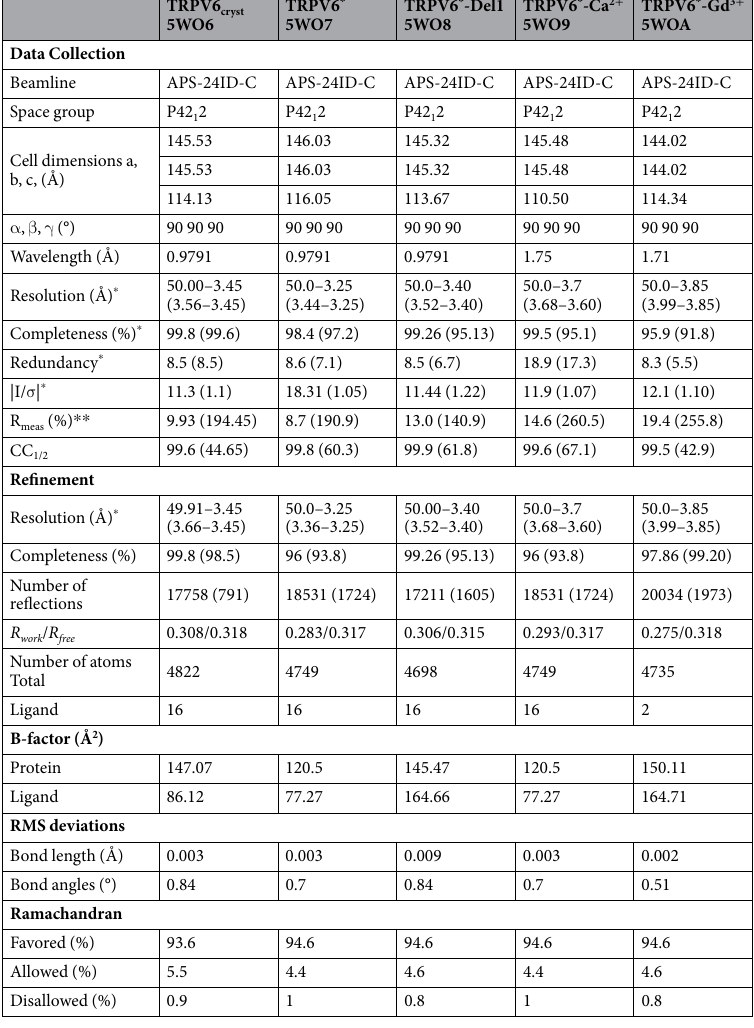
Table 1. Data collection and refinement statistics. * Highest resolution shell in parentheses. ** 5% of reflections were used for calculation of R free